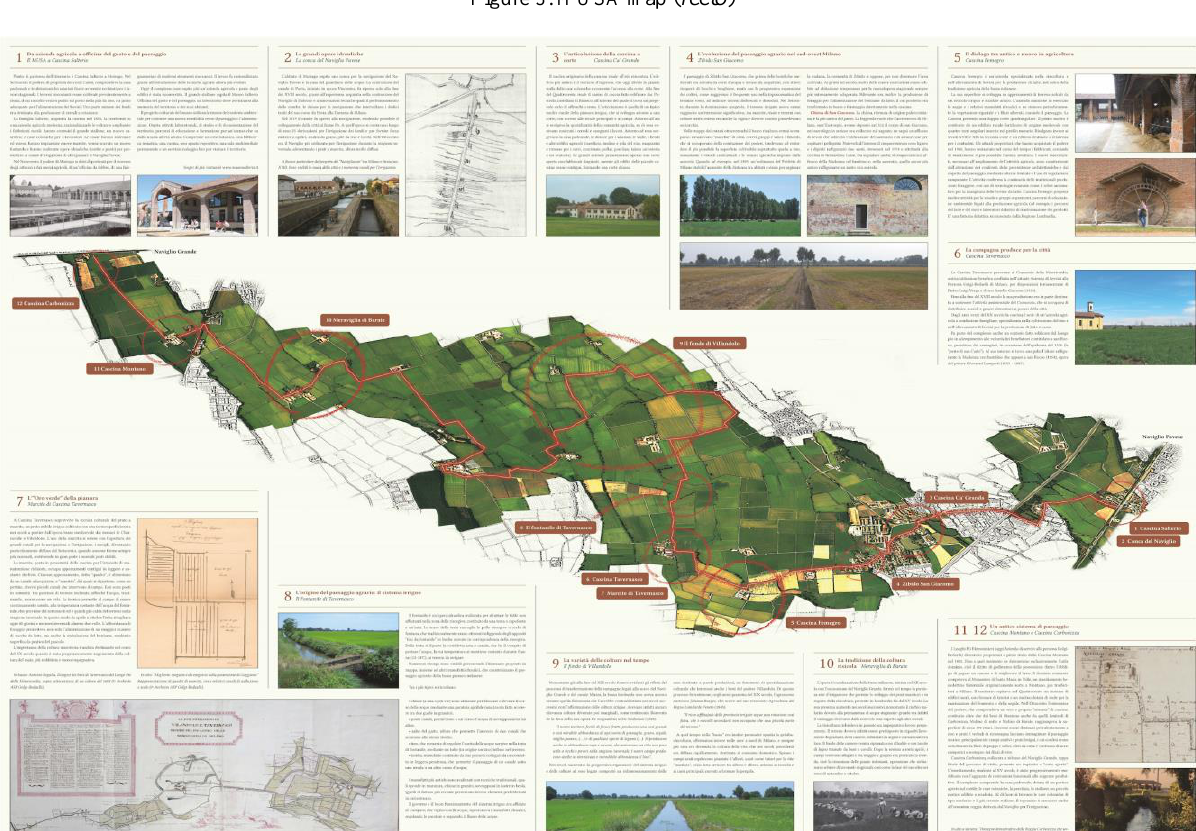
Figure 3. MUSA map ( recto )